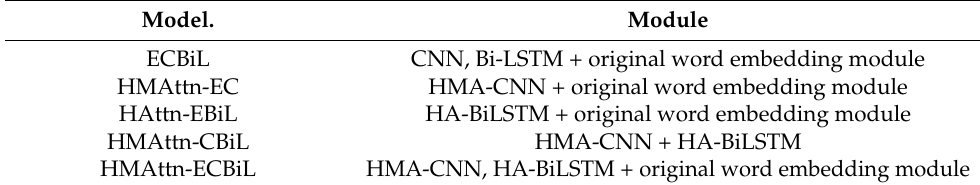
Table 4. Models composed of different